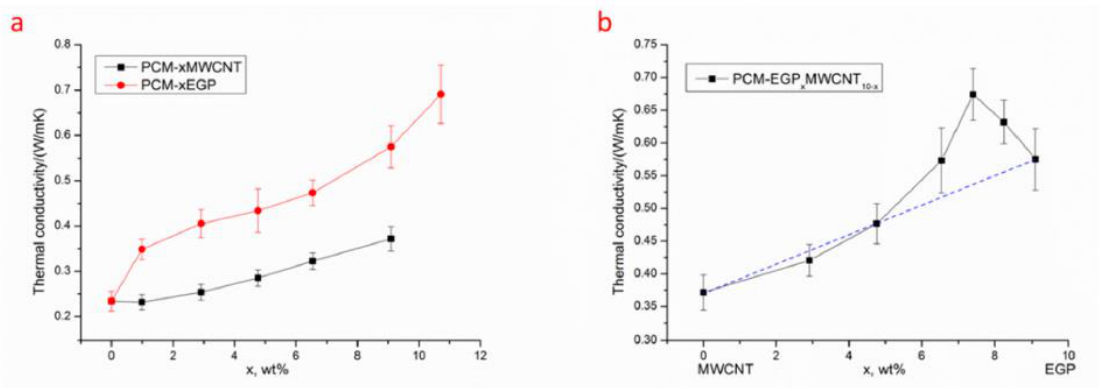
Figure 14. Thermal conductivities (at 35 °C) of SSPCM filled with ( a ) single filler and ( b ) hybrid filler [107].